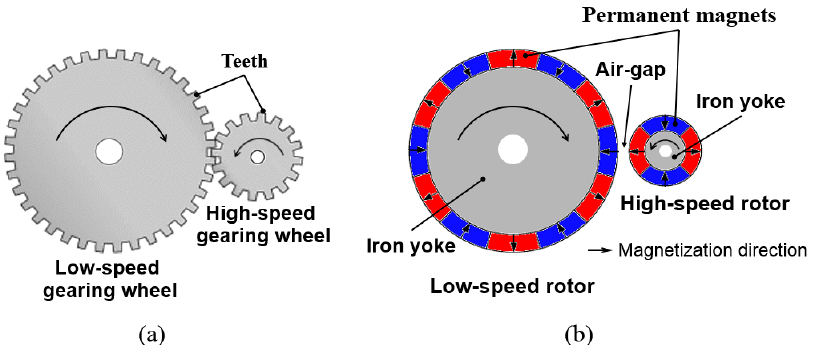
Figure 2. Equivalent gears: ( a ) Mechanical spur gear; ( b ) Magnetic spur gear.